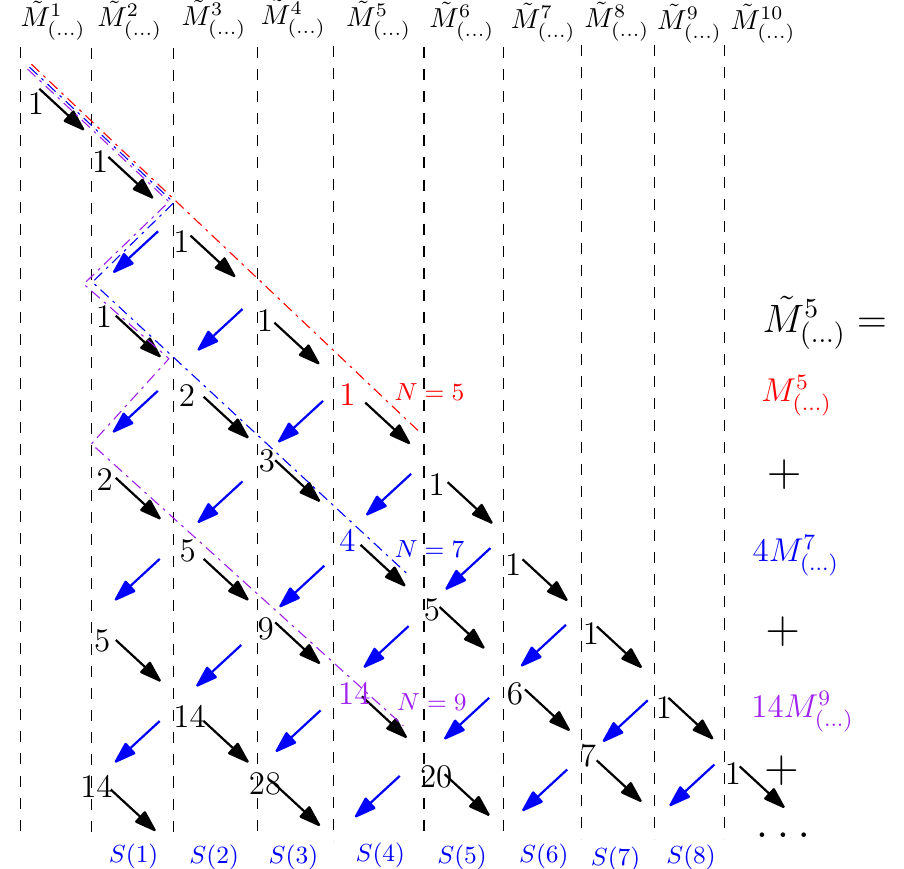
Figure 14. In each strip, numbers in vertices of a lattice correspond to terms in Formula (32). Each term is given by the multiplicity of a strip in the auxiliary lattice path model, the number of which is given by the length of a path, descending to the considered coefficient. As an example, we show formula for ˜ M 5 ( M , N )